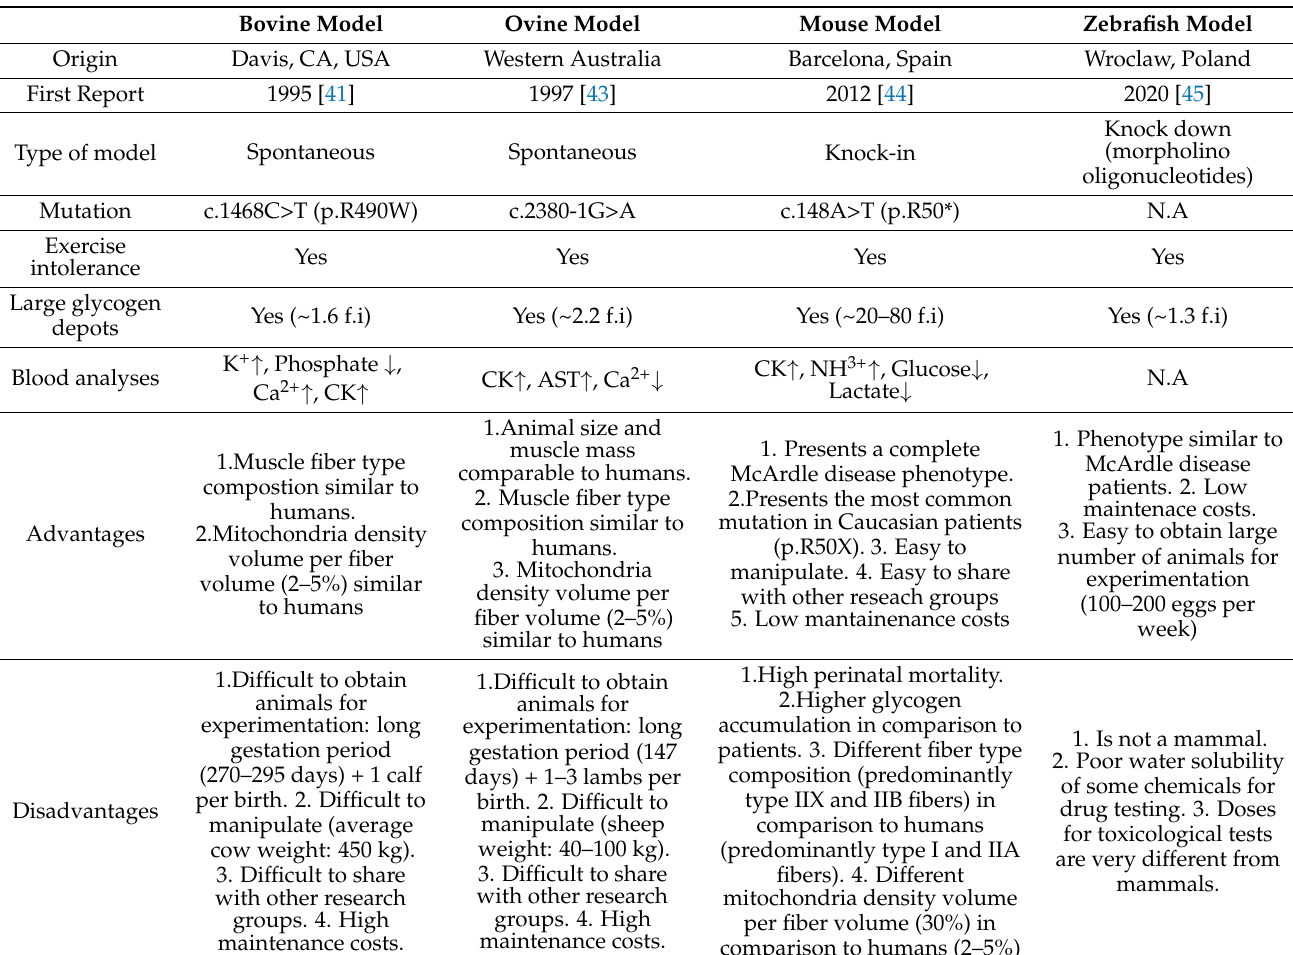
Table 1. The different preclinical research in vivo models for McArdle disease. Abbreviations: AST: Aspartate aminotransferase; CK: Creatine kinase; f.i: fold increase; N.A: not applicable; ↑ : increase; ↓ :